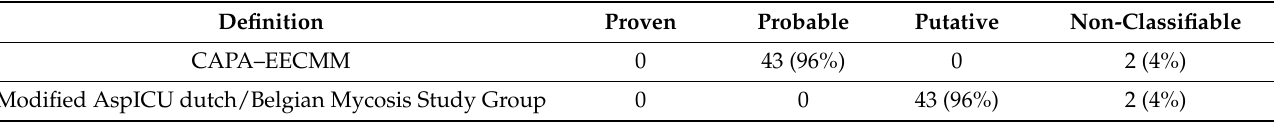
Table 2. Distribution of CAPA cases accordingly to [3,6]